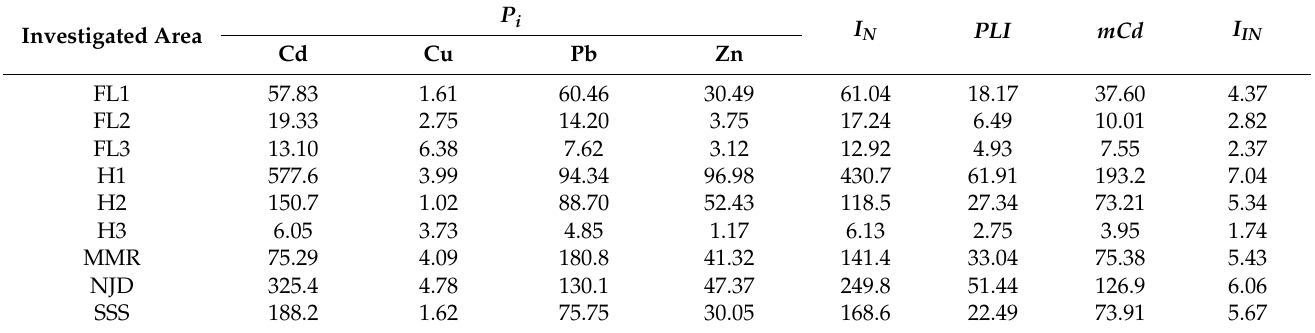
Figure 4. Semi-variance modeling of four kinds of total heavy metals. Table 6. Pi , I N , PLI , mCd and I IN of heavy